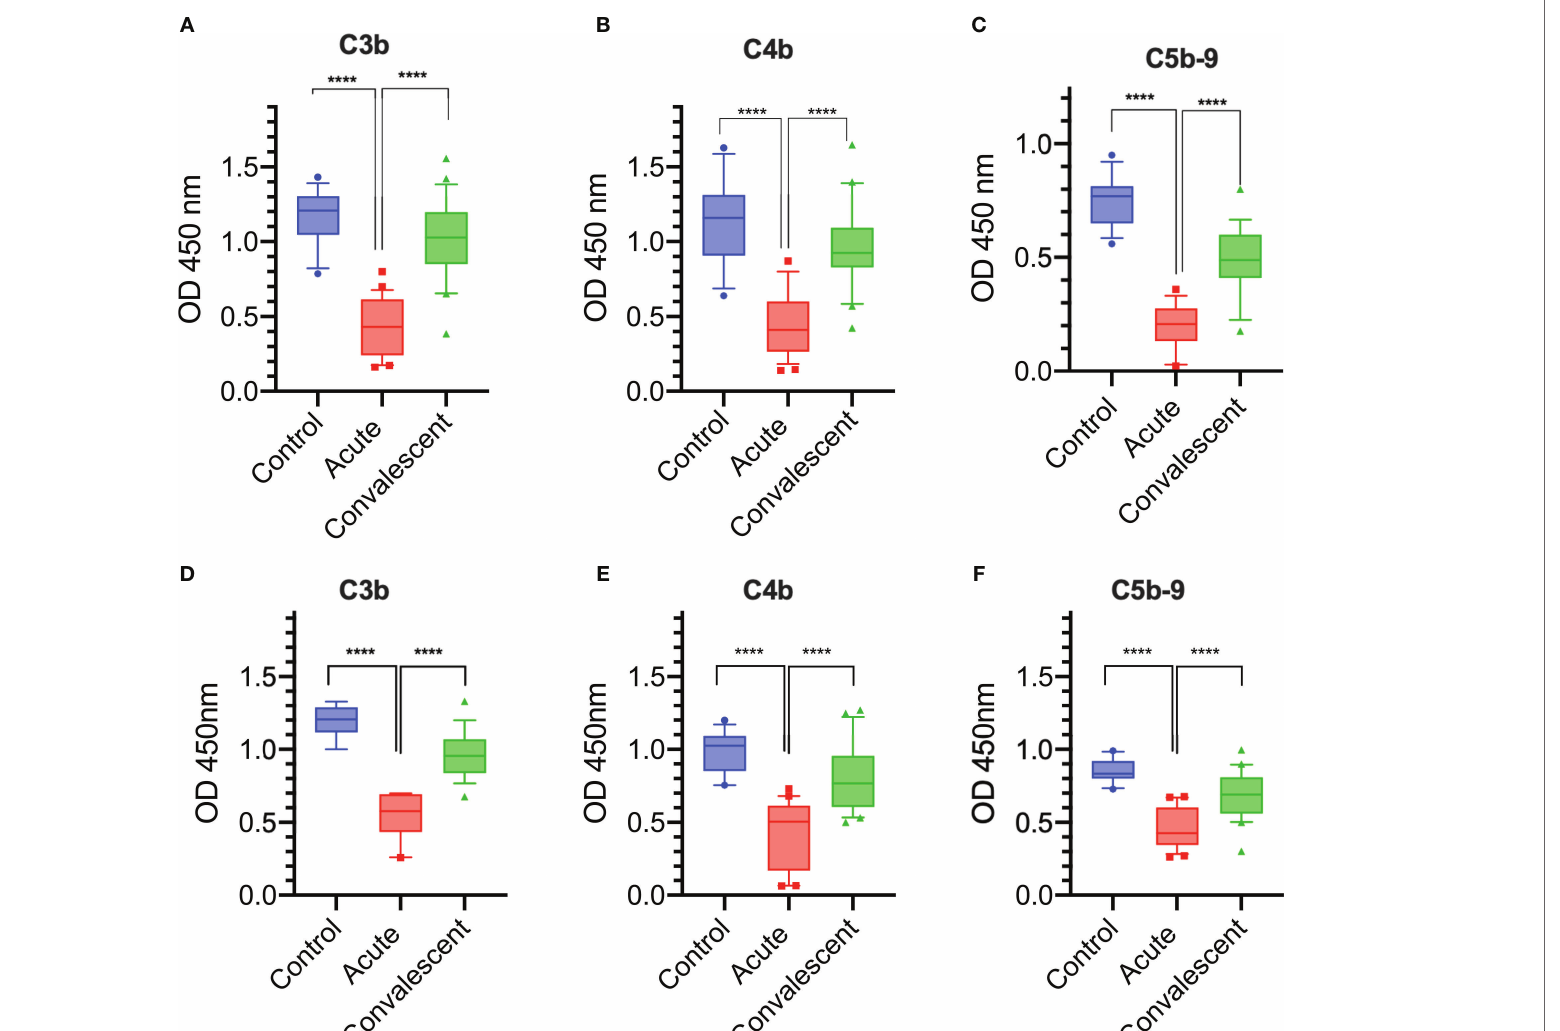
FIGURE 6 | Complement deposition on the surface of K. pneumoniae and S. aureus is impaired during acute severe COVID-19. A signi fi cant reduction in C3b, C4b, and C5b-9 deposition levels on the surface of mucoid K. pneumoniae (A – C) and on the surface of S. aureus (D – F) were detected when using sera from acutely ill patients compared to sera from the same patients taken 3 months after discharge (n = 25) or to control sera ( n= 14). Results were analyzed using 1-way ANOVA, with Dunnett ’ s correction for multiple comparisons. **** p <